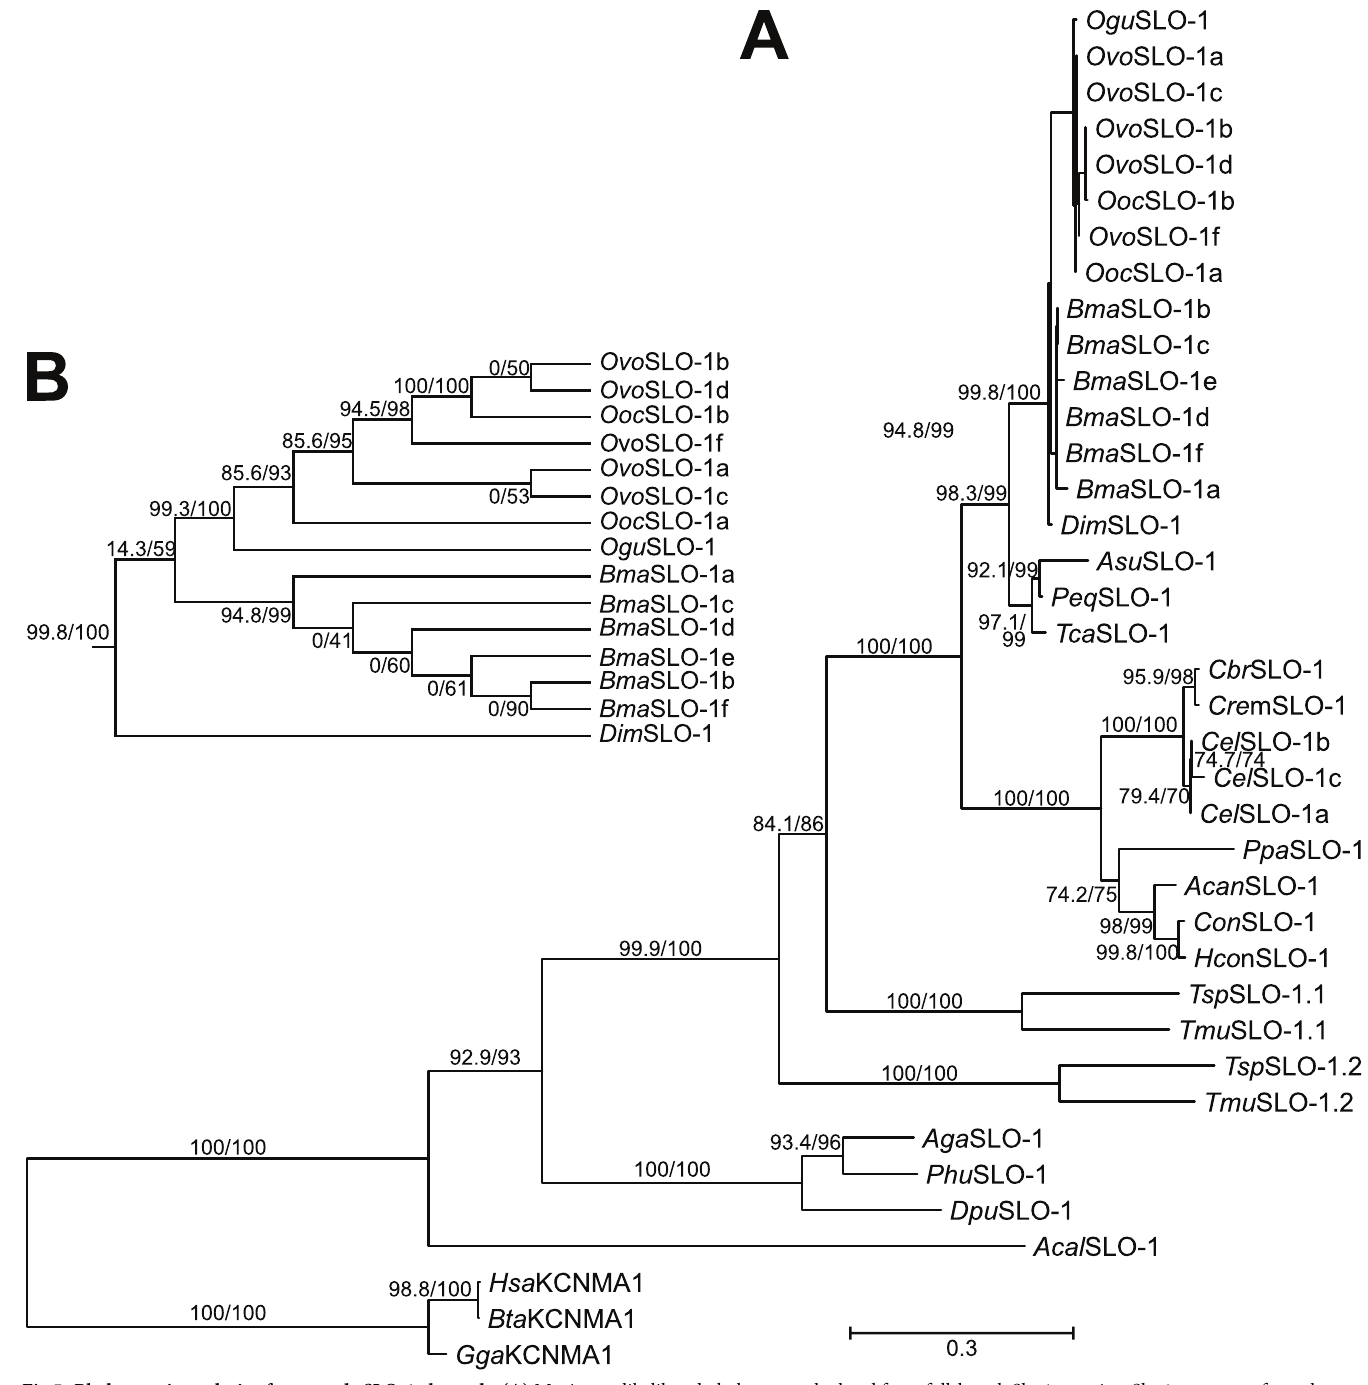
Fig 5. Phylogenetic analysis of nematode SLO-1 channels. (A) Maximum likelihood phylogram calculated from full-length Slo-1 proteins. Slo-1 sequences from the nematode species Cel , Cbr , Cre , Pca , Hco , Con , Acan , Ovo , Ooc , Ogu , Bma , Dim , Tca , Peq , Asu , Tmu , and Tsu were aligned with orthologs from Dme , Aga , Phu , Dpu , Acal , Gal , Bta , and Hsa , representing an outgroup, using MCoffee [69]. For Onchocerca spp. and Brugia malayi , all splice variants were included, but only the variants slo-1a-c for Caenorhabditis elegans . For all other species, only a single splice variant was used per gene. Accession numbers are available in S1 Table. ModelFinder [70] was applied to identify the optimal amino acid substitution model. The VT+G4 amino acid substitution model was used with a Γ shape alpha set to 0.4242 and the 4 substitution relative rate categories (with equal frequencies) of 0.0203, 0.1996, 0.7562, and 3.0239. Maximum likelihood trees were calculated with IQ-TREE [71] using 2,000 iterations of the Shimodaira–Hasegawa modification of the approximate likelihood ratio test (before the slash) and 2,000 ultrafast bootstrapping replicates (behind the slash). The scale bar represents 0.3 substitutions per site. (B) Enlarged cladogram showing the relationship of filarial SLO-1 proteins. For clarity, node support values